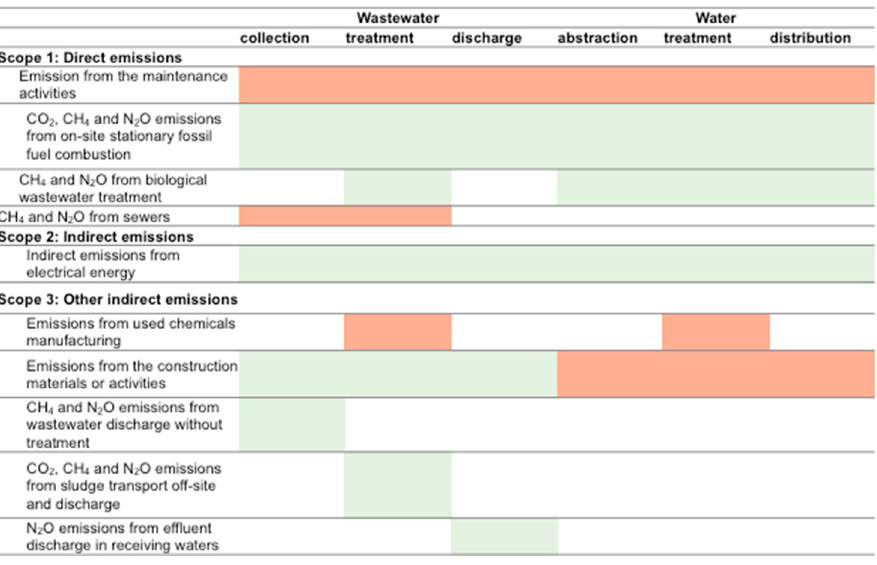
Figure 2. Types of emissions captured in this study.